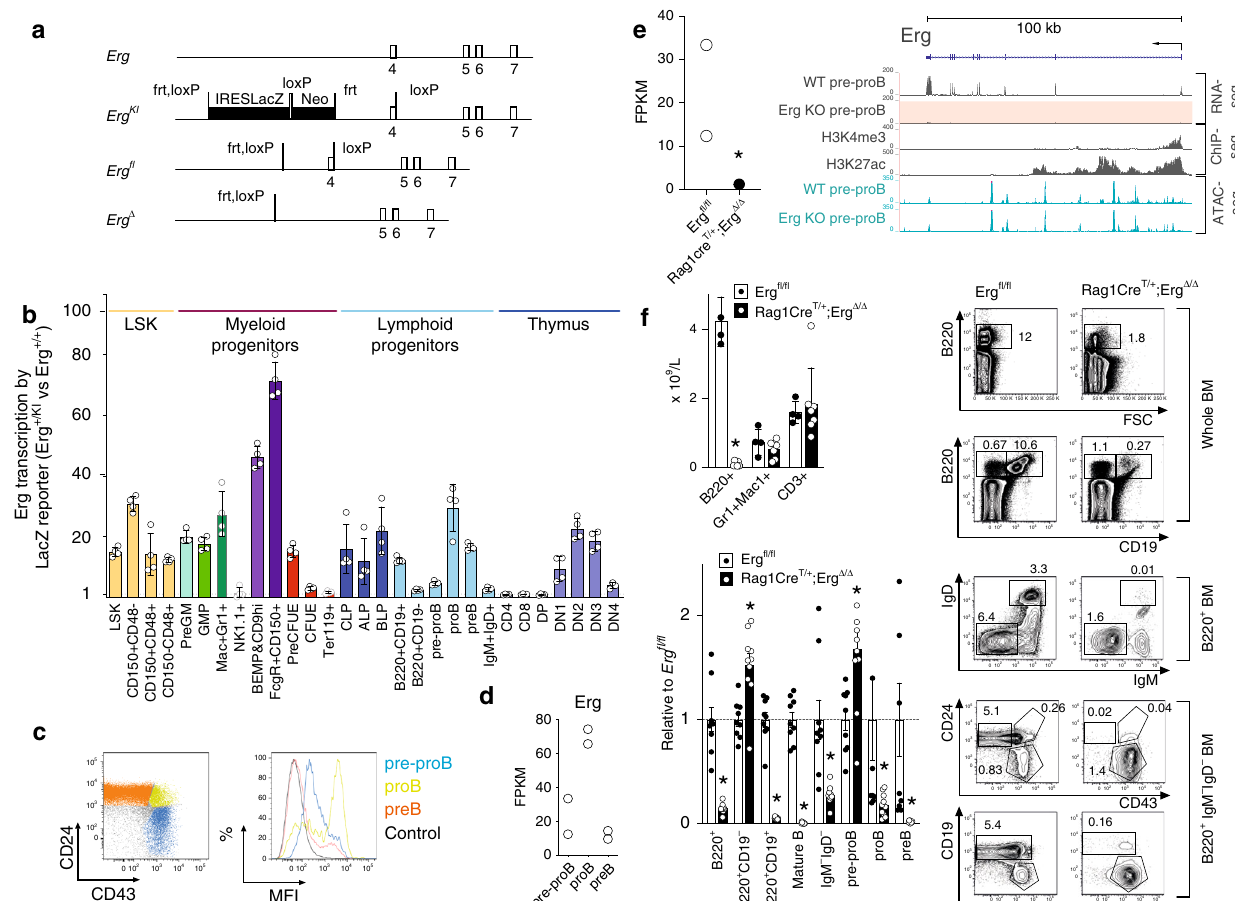
Fig. 1 Expression and targeted disruption of Erg in lymphopoiesis. a Wild-type ( Erg) , Erg tm1a(KOMP)wtsi lacZ reporter ( Erg KI ), conditional ( Erg fl ), and Cre recombinase-deleted ( Erg Δ ) alleles with exons, Cre (loxP) and Flp (frt) recombinase recognition sites. IRES, internal ribosome entry site; Neo, neomycin- resistance cassette. b Erg transcriptional activity by lacZ expression in Erg KI bone marrow (BM) and thymus cell populations (see “ Methods ” and Supplementary Fig. 1, Supplementary Table 1). Mean fl uorescent intensity (MFI) ratio mean ± S.D of Erg KI ( n = 4) to C57BL/6 ( n = 4) biologically independent samples. P adj < 0.028 by the Student ’ s two-tailed unpaired t test corrected using the Holm ’ s modi fi cation for multiple testing for each population except BM Ter119 + and NK1.1 + , and thymic DP, CD4 + CD8 − and CD8 + CD4 − populations ( P adj > 0.05). c Representative fl ow cytometry plots: BM pre – proB (blue), proB (green), preB (orange) and control wild-type (black) B220 + IgM − IgD − (left) with lacZ MFI (right). d Erg expression by RNA-seq (mean ± SD, Fragments Per kilobase of transcript per million mapped reads, FPKM) in Erg fl / fl pre – proB, proB and preB cells ( n = 2 biologically independent samples) e Erg RNA-seq (FPKM) in Erg fl / fl and Rag1Cre T/ + ;Erg Δ / Δ pre – proB cells ( n = 2 biologically independent samples; *edgeR two-sided adjusted P value for multiple comparisons = 1.41e − 5, Supplementary Data 1) and Erg locus RNA-seq in Erg fl / fl (WT) and Rag1Cre T/ + ; Erg Δ / Δ (Erg KO, with pink highlighting absent expression) in pre – proB cells, H3K4me3 and H3k27ac ChIP-seq in wild-type proB cells and chromatin accessibility (ATAC-seq, blue). f Erg fl / fl ( n = 4) and Rag1Cre T/ + ; Erg Δ / Δ ( n = 7) biologically independent samples: B220 + B-cell, Gr1 + Mac1 + myeloid cell, and CD3 + T-cell blood counts, mean ± SD; * P = 6.6e − 8 by the Student ’ s two-tailed unpaired t test (top left). B-lymphoid populations in Erg fl / fl ( n = 9) and Rag1Cre T/ + ;Erg Δ / Δ ( n = 10) biologically independent samples: BM as ratio of cell number to Erg fl / fl (mean± SD, bottom left, see Supplementary Table 1). * P adj = 3.5e − 6 (B220 + ), 3.5e − 3 (B220 + CD19 − ), 4.9e − 10 (B220 + CD19 + ), 3.0e − 10 (IgM + IgD + ), 3.5e − 3 (IgM − IgD − ), 1.7e − 2 (pre – proB), 4.0e − 2 (proB), 1.7e − 2 (preB) by the Student ’ s two-tailed unpaired t test corrected using the Holm ’ s modi fi cation for multiple testing. Representative fl ow cytometry plots (right) with mean percentage of viable cells indicated. Source data are provided in the Source data fi